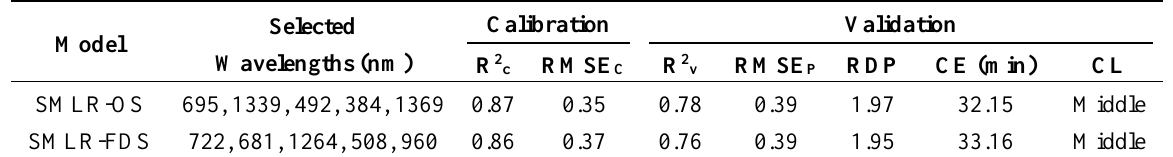
Table 5. The best-performing LNC models based on stepwise multiple linear regressions (SMLR) for the calibration and validation sets.